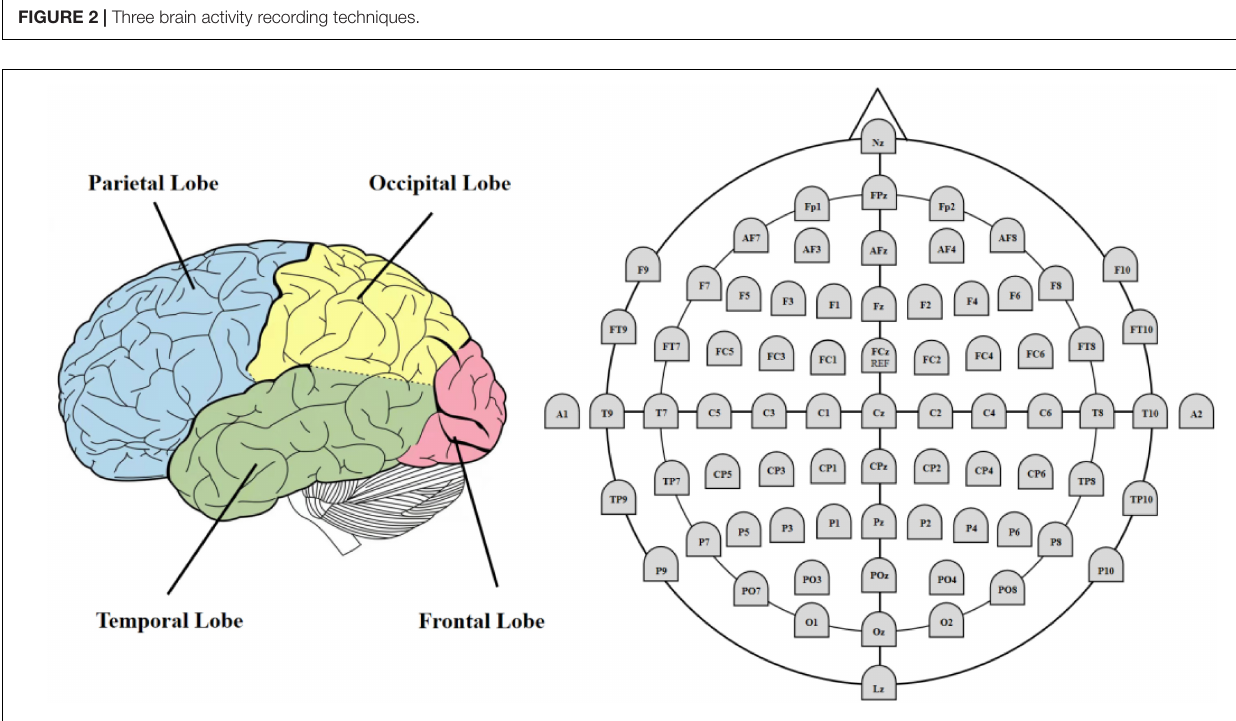
FIGURE 2 | Three brain activity recording techniques.